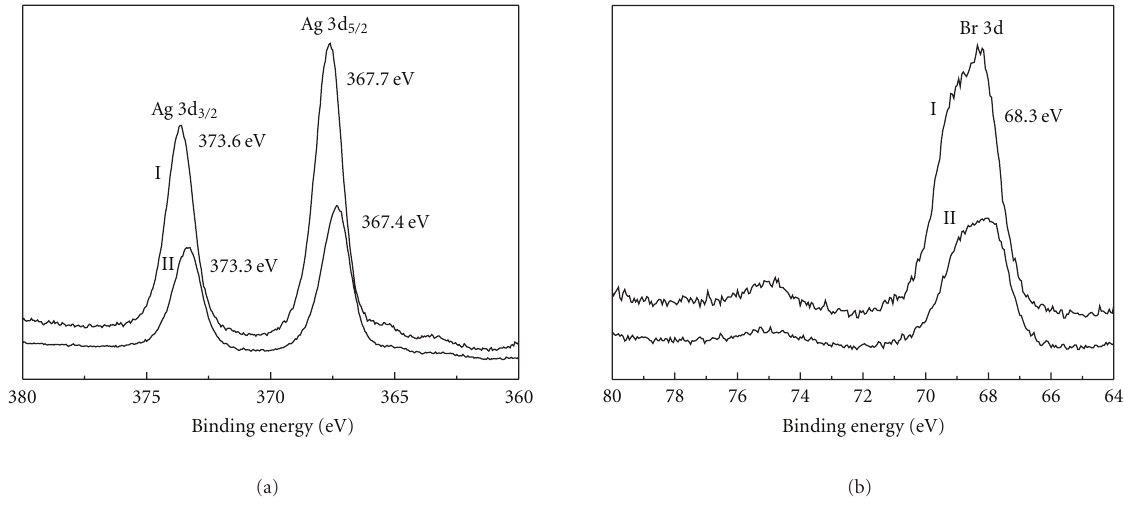
/m = 3 . 35). I: before reaction, II: after the 5th reaction TiO 2 3